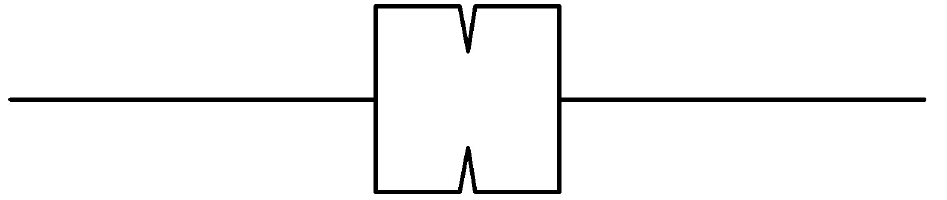
Fig 16. Rock creep crack evolution element (Mo’s